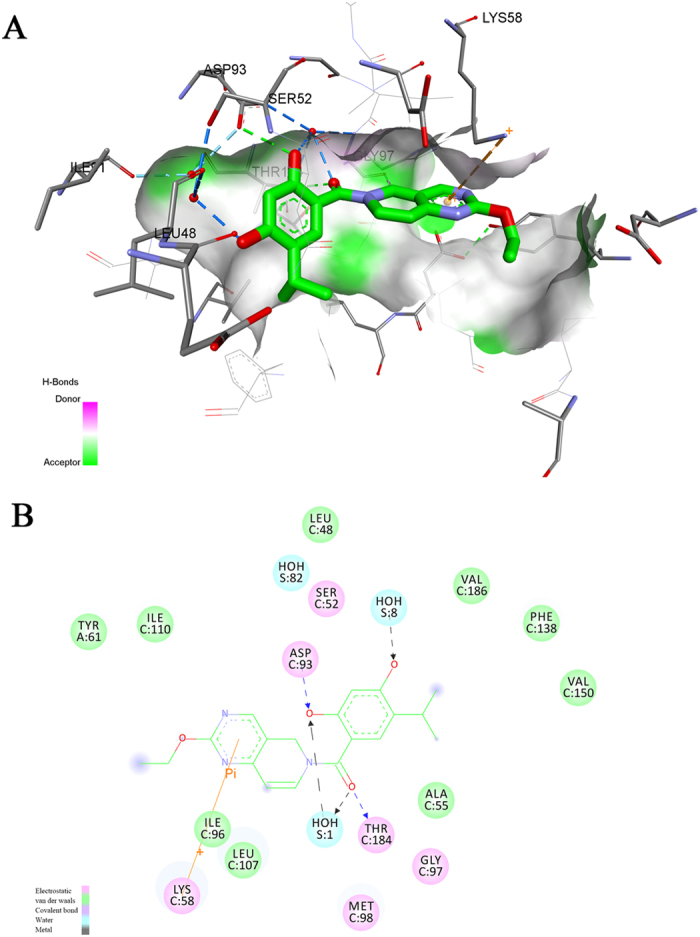
The binding mode between CPUY201112 and the ATP-binding site of Hsp90.(A) The 3D diagram of CPUY201112 binding to Hsp90. CPUY201112 is shown as a stick, with carbon atoms colored in green, oxygen atoms colored in red and nitrogen atoms colored in blue. The surface was added to the binding site of Hsp90, and the key residues in Hsp90 for binding were shown as sticks colored in grey. Intermolecular interactions were described using dot lines. (B) The 2D diagram of CPUY201112 binding to Hsp90. Different intermolecular interactions are shown in various colors. The figure was prepared in Discovery Studio 4.0.